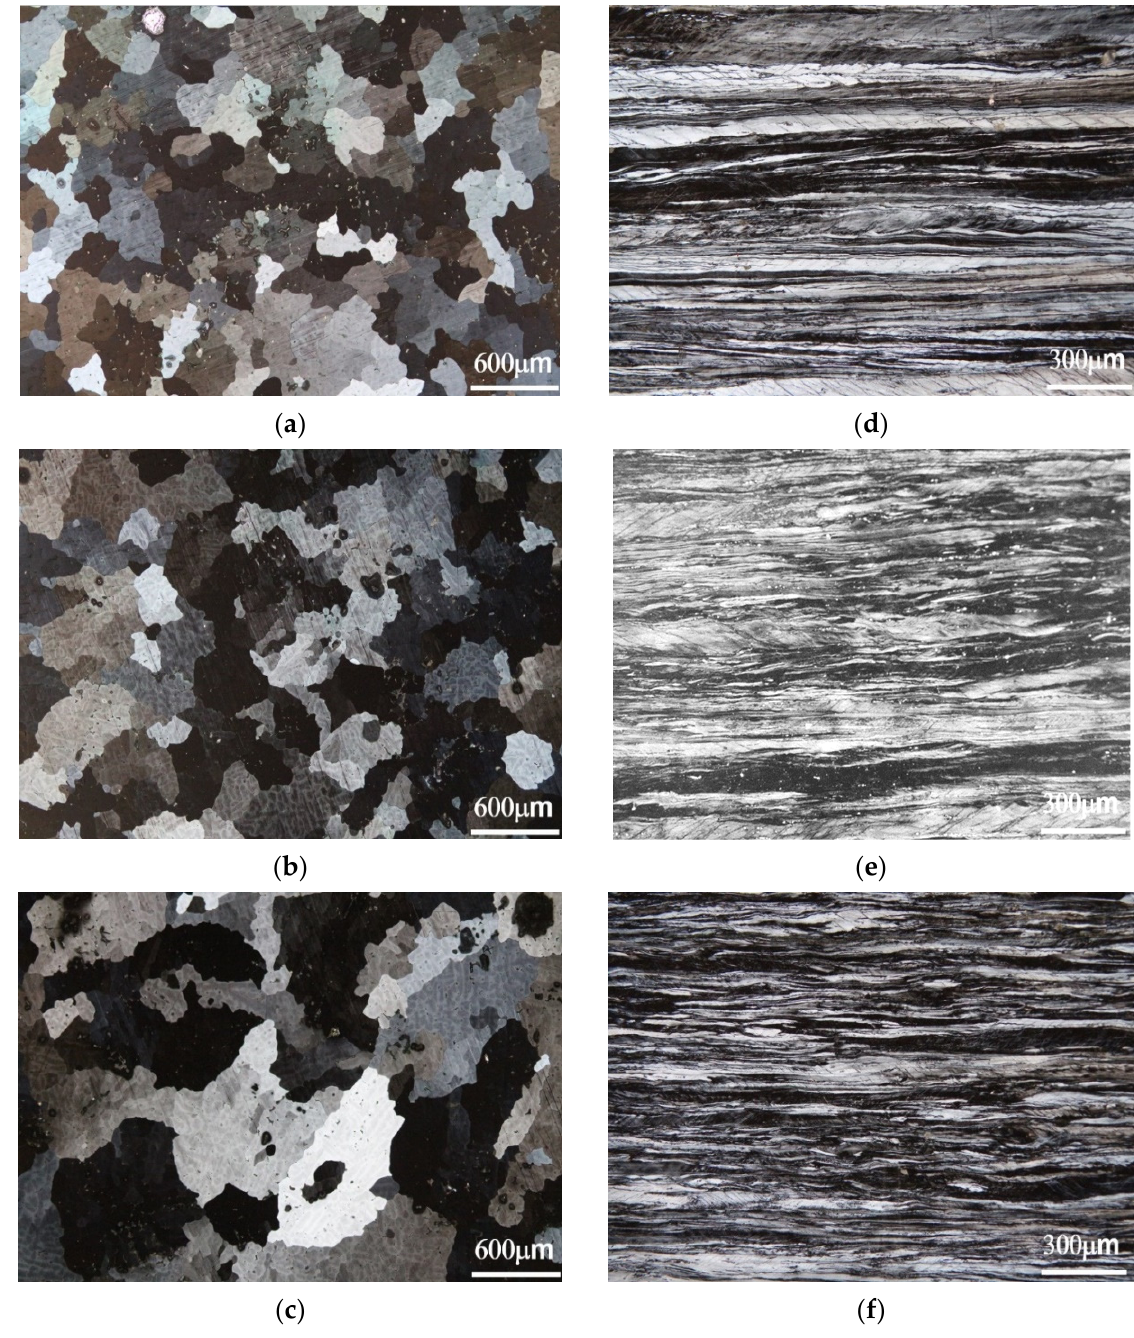
Figure 2. OM metallography: ( a ) metallography of as-cast alloy A(0.1Mn); ( b ) metallography of as-cast alloy B(0.1Zr); ( c ) metallography of as-cast alloy C(0.05Sc); ( d ) metallography of H18 alloy A(0.1Mn); ( e ) metallography of H18 alloy B(0.1Zr); ( f ) metallography of H18 alloy